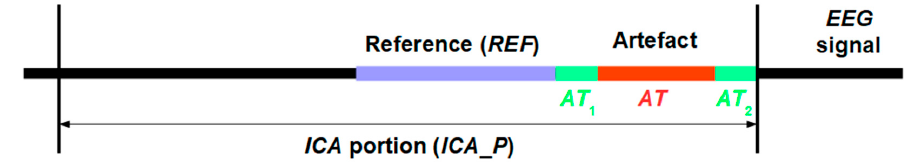
Figure 6. Notation of some parts around a detected artefact (for an EEG channel) used in the automatically remove artefacts (UAR)